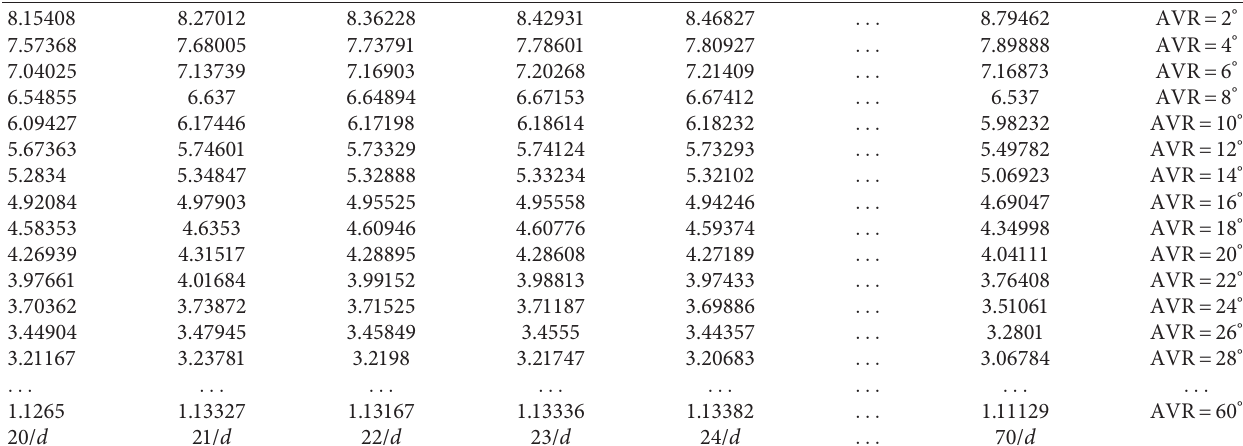
Table 3: Raimondi’s tables completed with the results of dividing the D value of each column by the values obtained on the regression